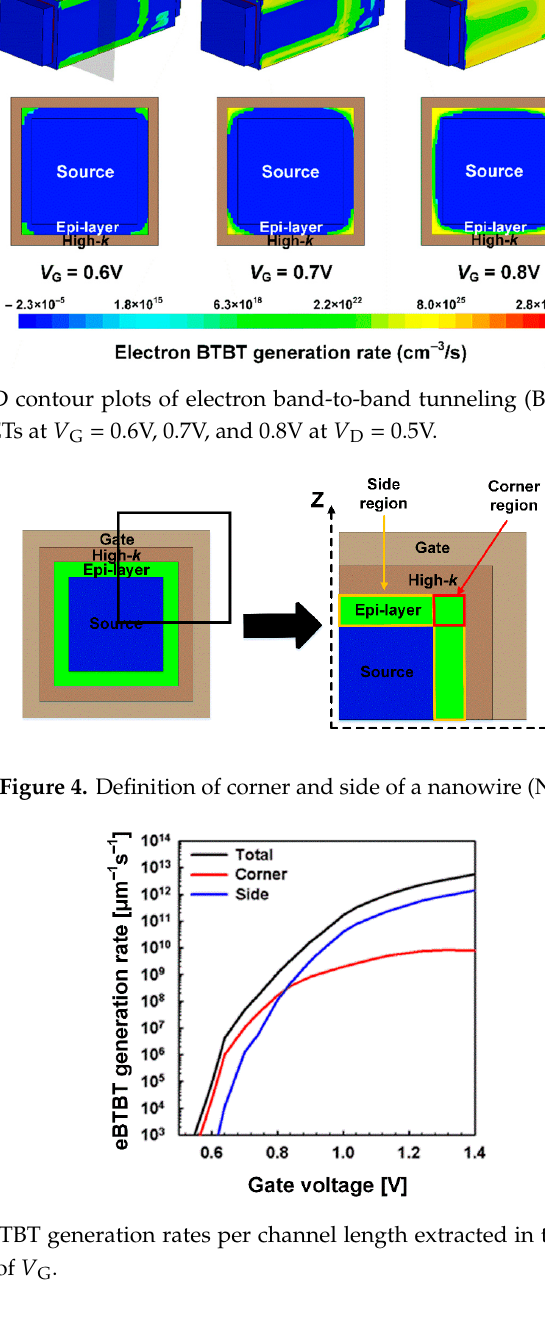
Figure 6. ( a ) 2D contour of electrostatic potential distribution at V G = 1.5 V, ( b ) electrostatic potential of cut line as V G increases (0.5 V–1.5 V), ( c ) surface potential at the corner and side.